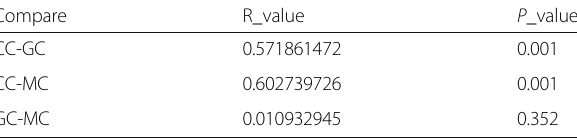
Table 4 Weighted_unifrac adonis analysis Compare F_value R2 P _value